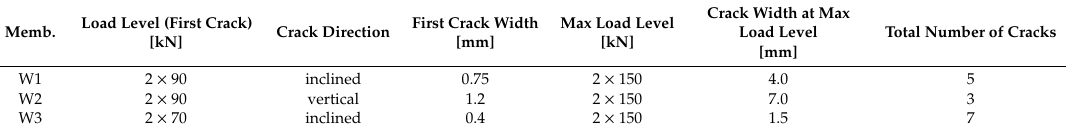
Table 7. Crack widths depending on load level.